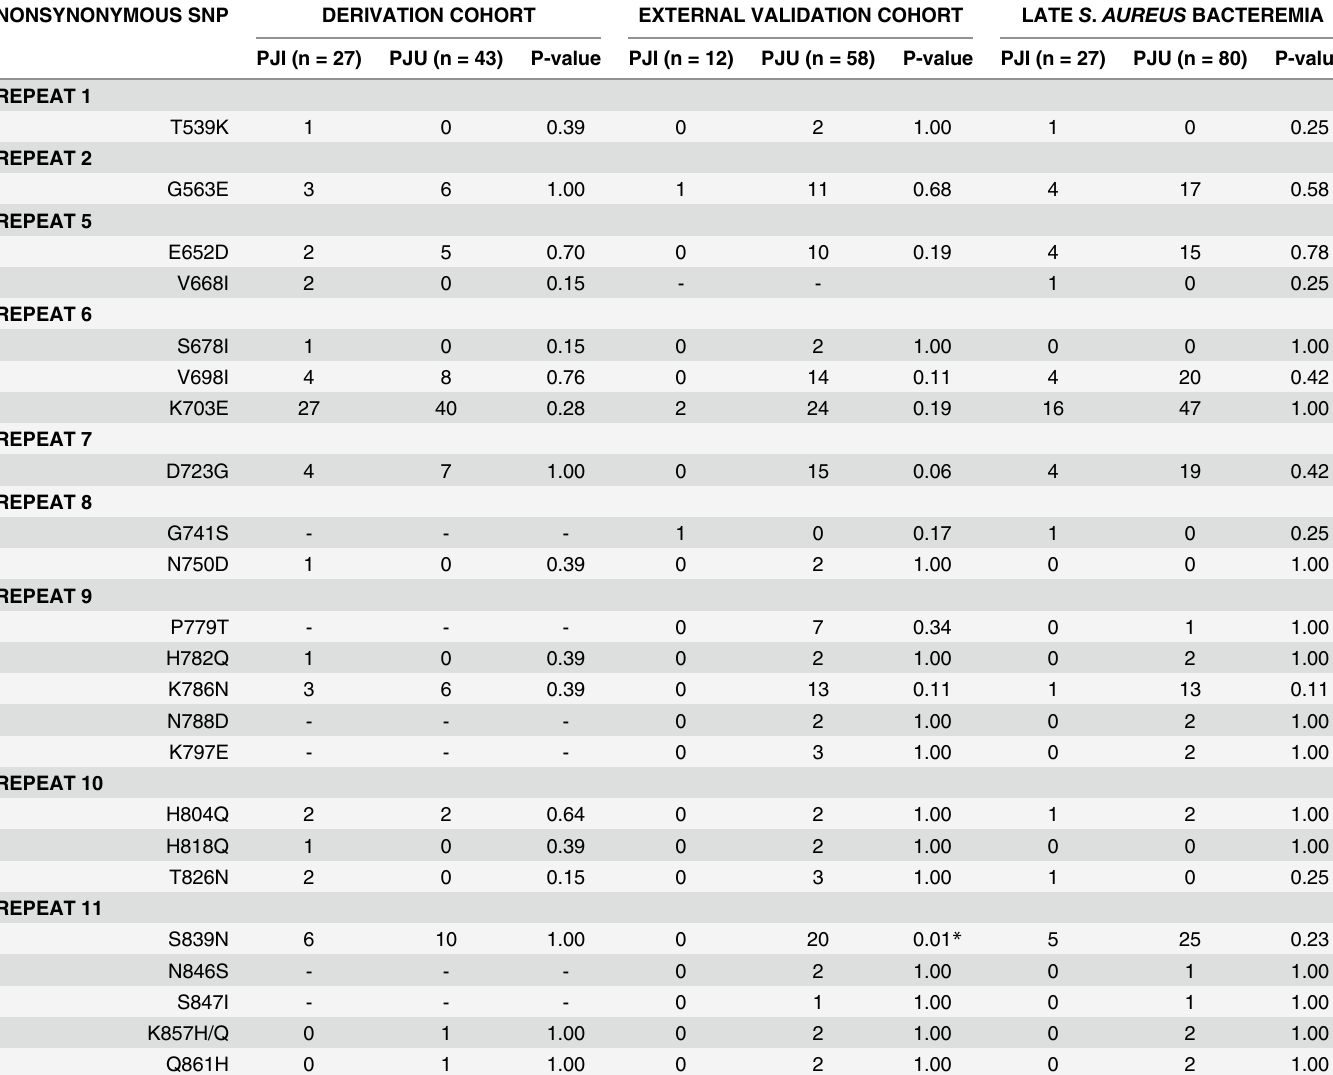
Table 2. Single Nucleotide Polymorphisms (SNPs) in fibronectin binding protein A ( fnbA) in the derivation cohort, external validation cohort, and late S . aureus bacteremia (SAB) group. In the derivation cohort, no SNPs occurred with greater frequency in the prosthetic joint infection group (PJI) rela- tive to the uninfected prosthetic joint group (PJU). In the external validation cohort, one SNP (S839N) was significantly associated with the PJU group, though when the two cohorts were combined the S839N association did not reach statistical significance (p = 0.22). Late SAB was defined as bacteremia occurring > 1 year after placement or manipulation of prostheses, and here contains data from both the derivation and external validation cohorts. In the late SAB group, no SNPs occurred with greater frequency in PJI or